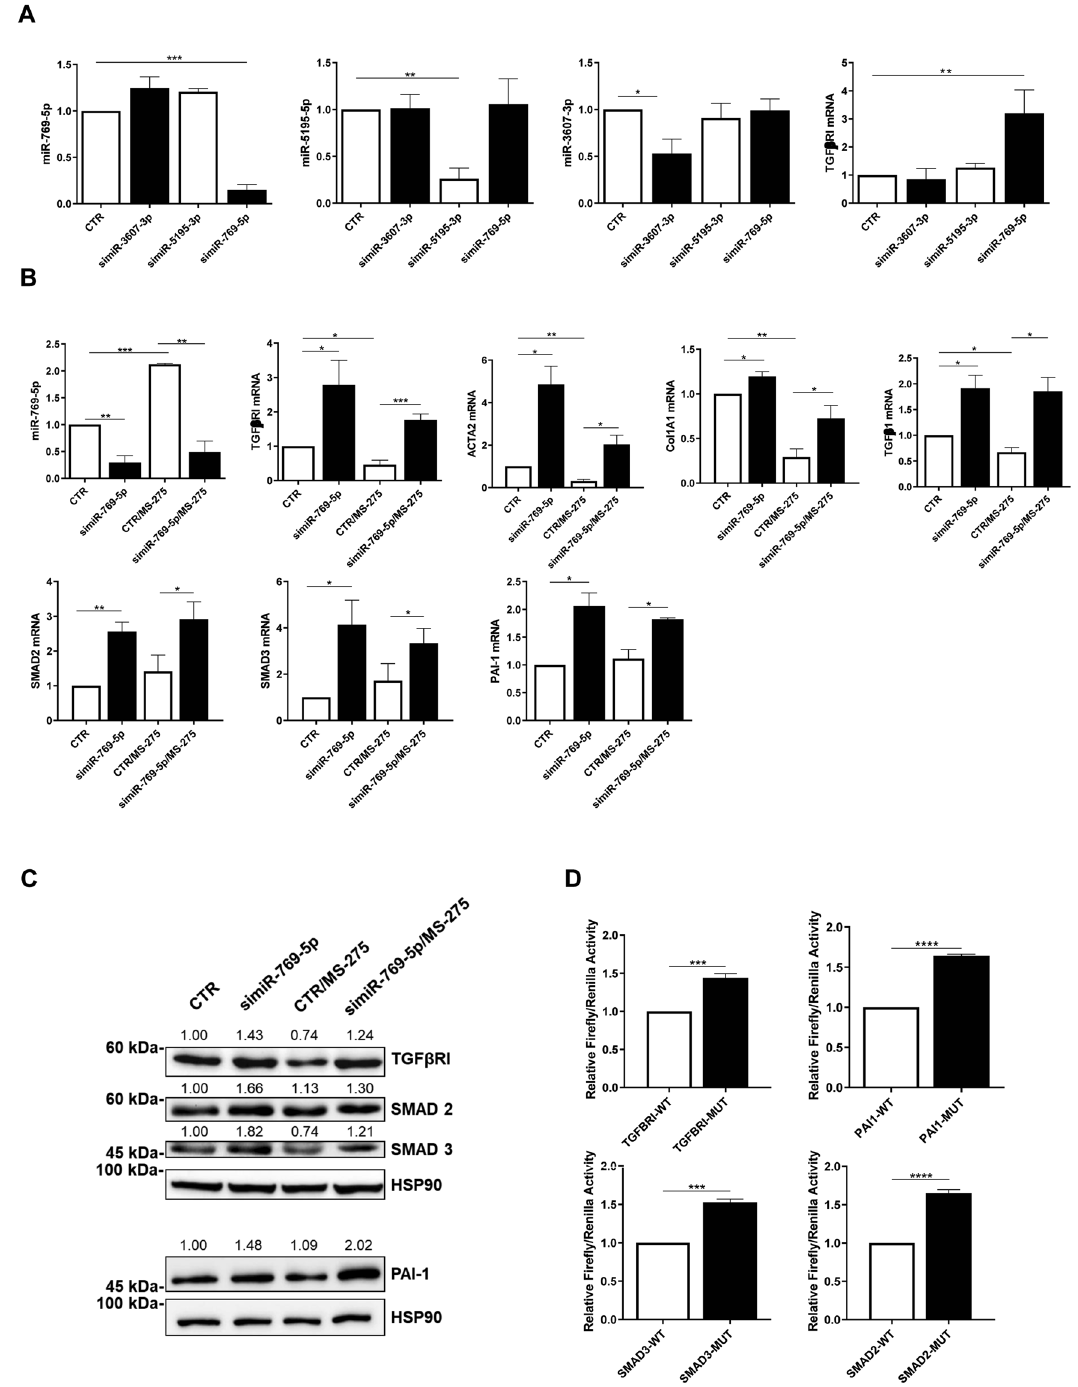
Fig. 2 miR-769-5p genetic silencing reverses the effects of MS-275 in the expression of TGF β RI and other MMT-related markers. A RT-PCR showing the effect of miR-769-5p, miR3607-3p and miR5195-3p speci fi c silencing on TGFBRI mRNA expression in MCs from PD patients. miR- 16 was used for normalization. Bars represent the mean ± SEM of duplicate determinations in three to fi ve independent experiments. B RT- PCR showing the effect of miR-769-5p genetic silencing on the expression of TGFBRI, ACTA2, COL1A1, TGF β 1, SMAD2, SMAD3 and PAI-1 in the presence of MS-275. Quantitative RT-PCR was performed on total RNA. L34 mRNA levels were used for normalization. Bars represent the mean ± SEM of duplicate determinations in three to four independent experiments. C WB showing the expression of TGFBRI, PAI-I, SMAD2 andSMAD3 upon genetic silencing of miR-769-5p. HSP90 was used as a loading control. Data are representative of three independent experiments. D Dual luciferase reporter gene assay showing the speci fi c targeting of TGFBRI, SMAD2, SMAD3 and PAI-1, by miR-769-5p Bars represent the mean ± SEM of duplicate determinations in four to fi ve independent experiments performed in MeT5A cells.